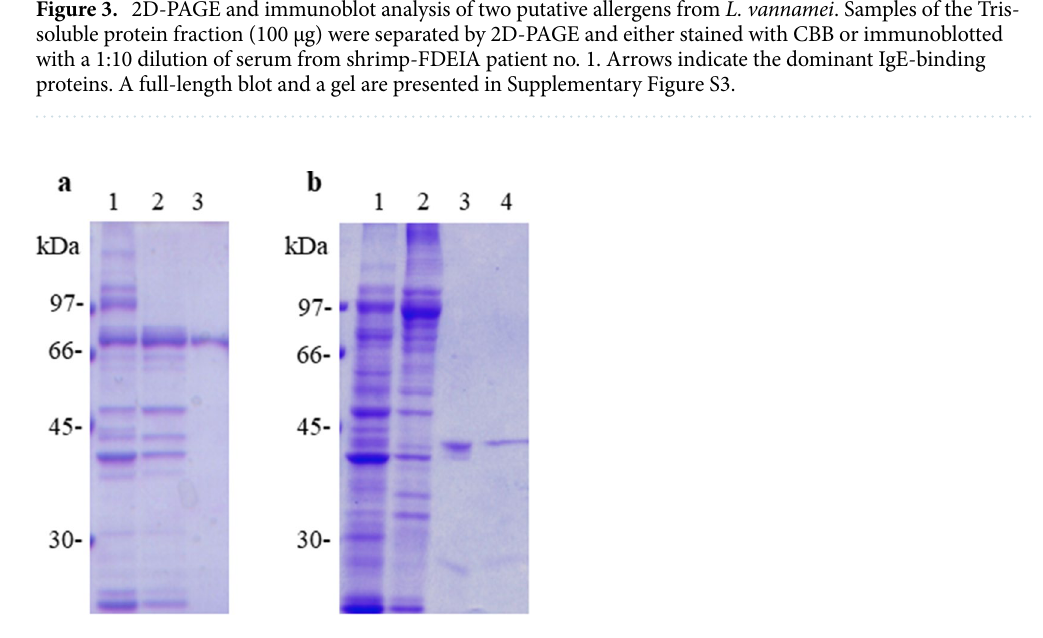
Figure 4. Purification of P75 homologue and FBPA proteins from L. vannamei . ( a ) CBB staining of a 70-kDa protein in the whole Tris-soluble fraction (lane 1), the 40–60% ammonium sulfate precipitate (lane 2), and reversed-phase HPLC fraction (lane 3). ( b ) CBB staining of a 43-kDa protein in the whole Tris-soluble fraction (lane 1), 20–40% ammonium sulfate precipitate (lane 2), anion-exchange chromatography fraction (lane 3), and hydrophobic interaction chromatography fraction (lane 4). Full-length gels are presented in Supplementary Figure